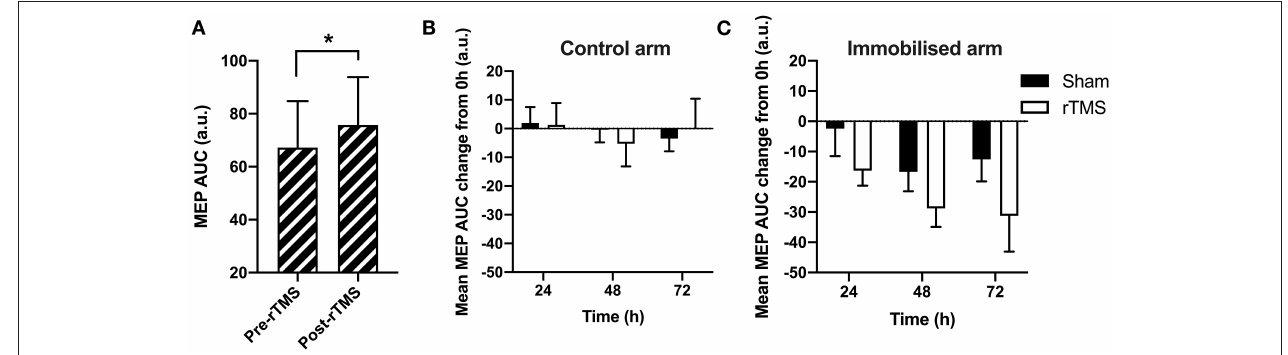
FIGURE 4 | The effect of rTMS on the immobilization-induced loss of motor excitability. (A) There was a significant effect of rTMS on MEPs at 0h ( p < 0.05). (B) In the control arm, there was no significant change in MEP size across time or between Sham and rTMS ( p > 0.05). (C) In the immobilized arm, there was a decrease in MEPs across time ( p < 0.05), which did not differ between Sham and rTMS ( p > 0.05). * p < 0.05.